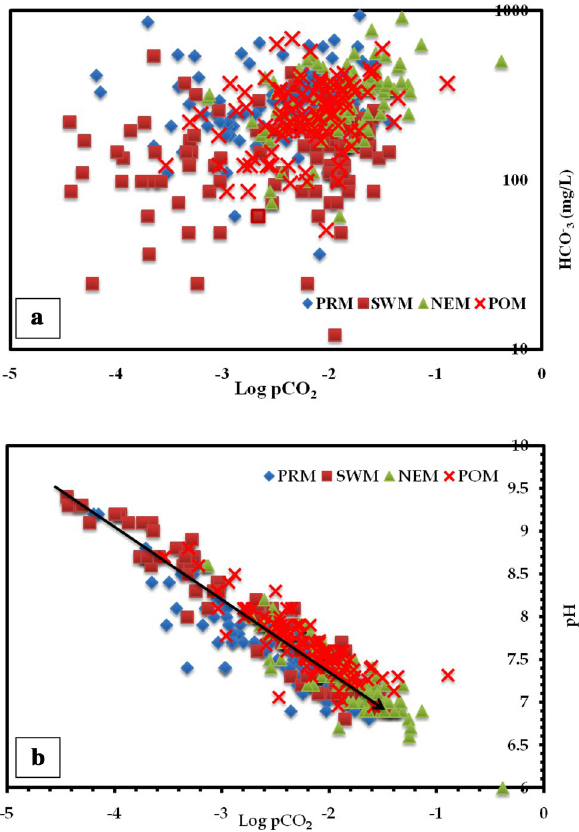
HCO − Fig. 6 a Log pCO 3 and b Log pCO 2 versus pH relation- 2 versus ship of groundwater samples for different seasons